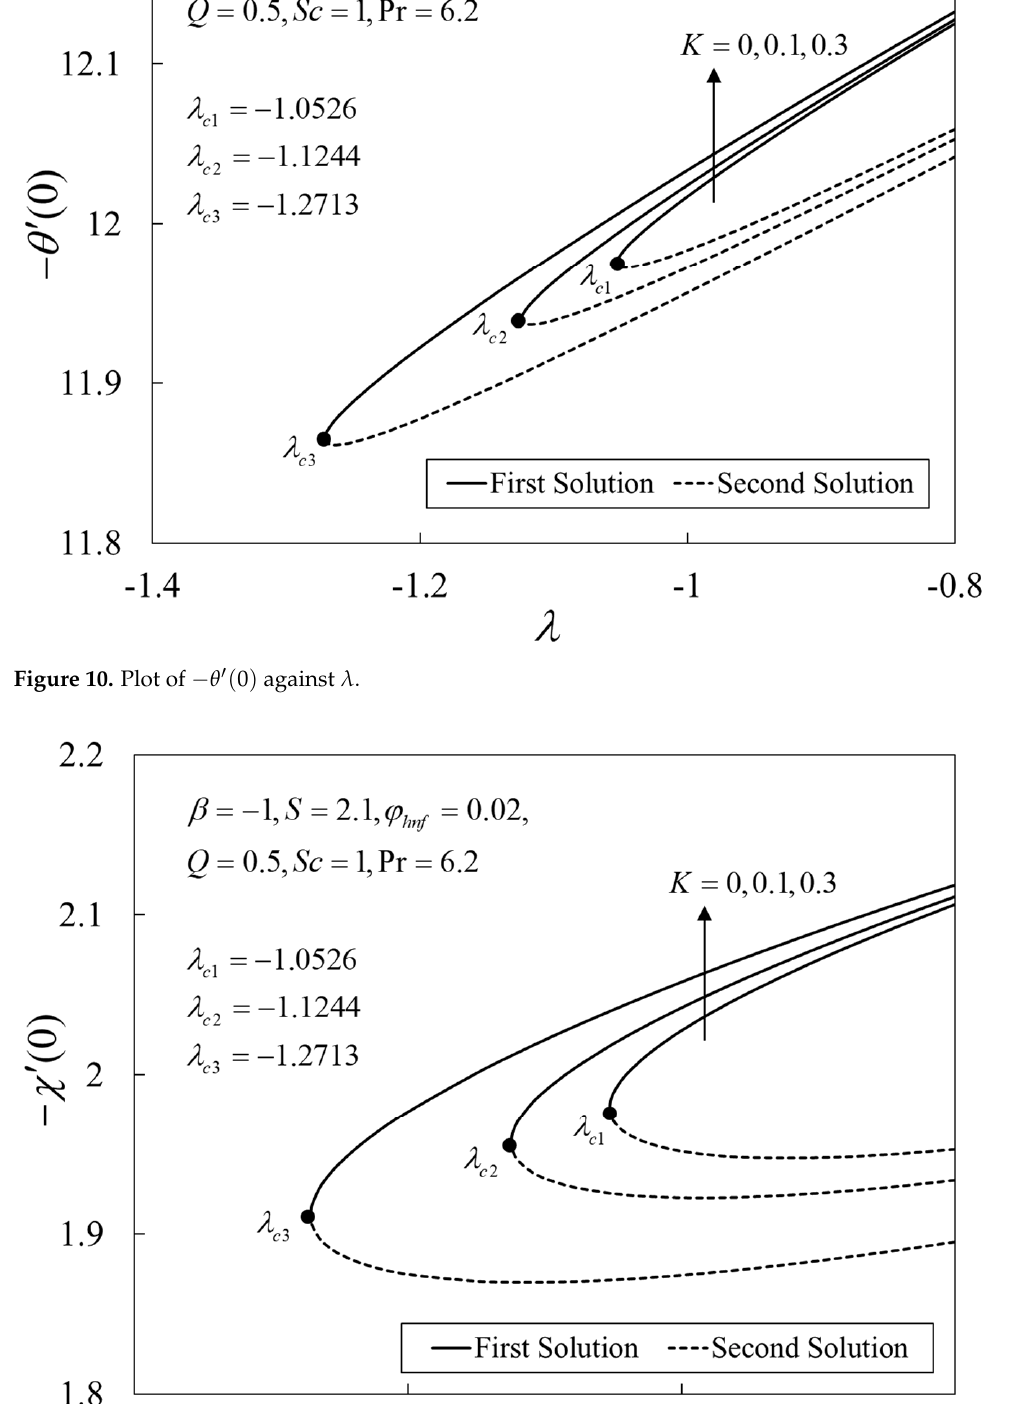
(cid:48) ( 0 ) against λ